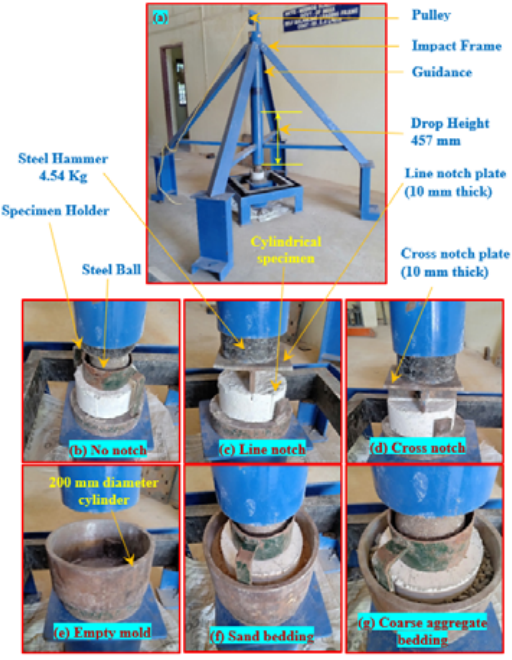
Figure 7. Drop weight test setup and arrangements.